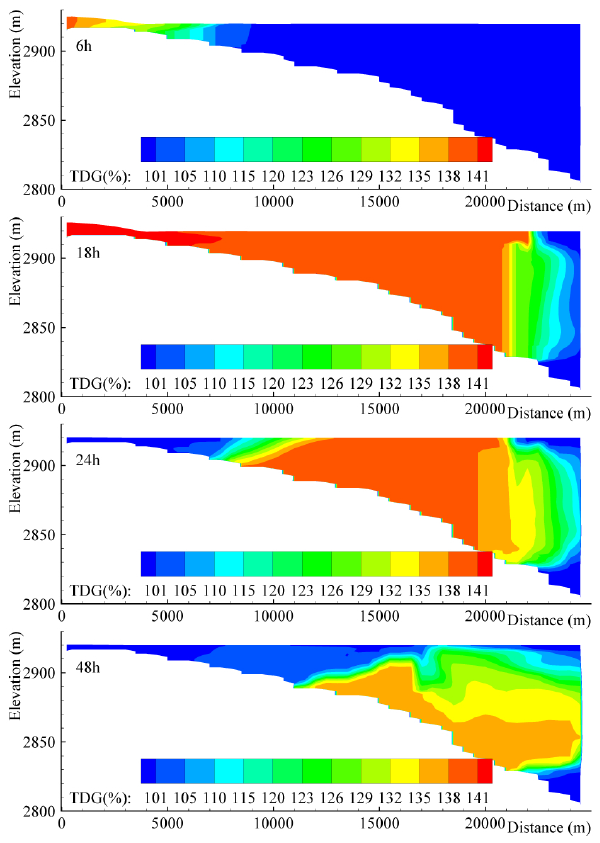
Fig. 10. The TDG distributions at the key moments (Case 3).